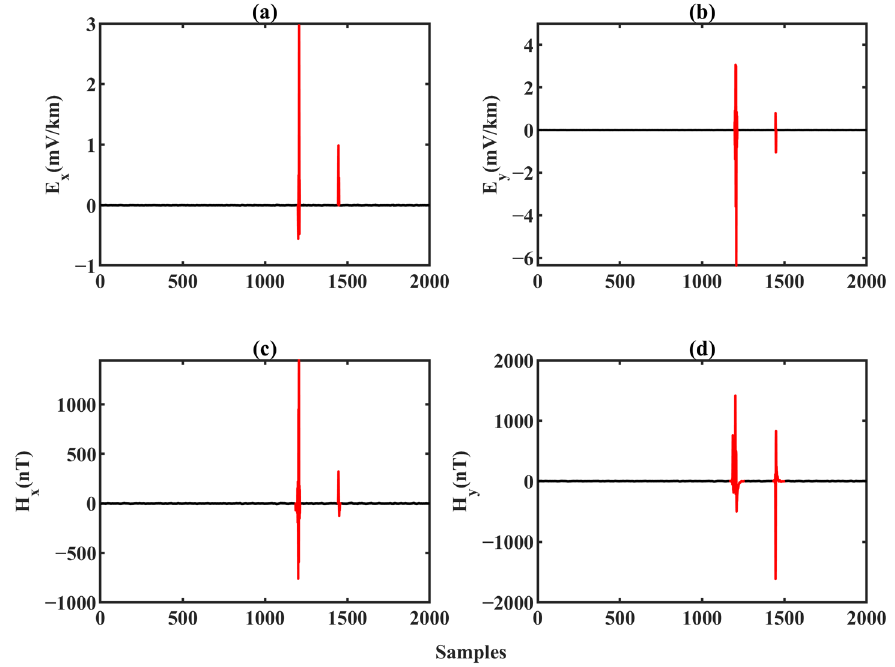
Figure 8. The amplified sections in the 5th test dataset. MT noise identification of ( a ) e x , ( b ) e y , ( c ) h x , and ( d ) h y time